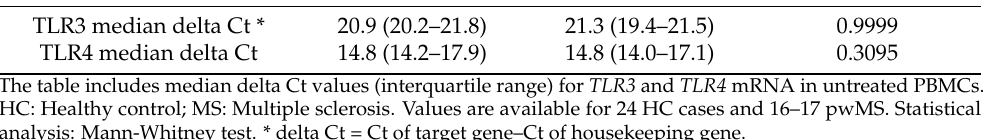
Table 2. Constitutive expression of TLR3 and TLR4 mRNA in PBMCs from HCs and pwMS. Target